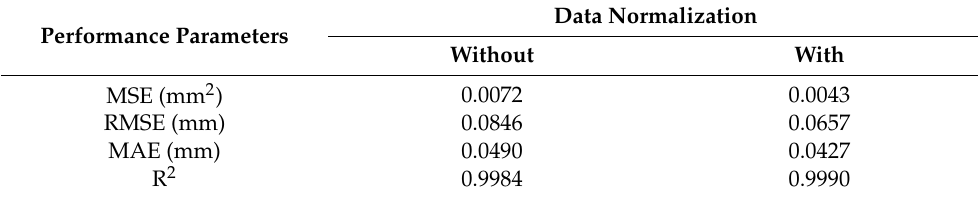
Table 7. The effect of data normalization on the predictive performance of the ANN-based